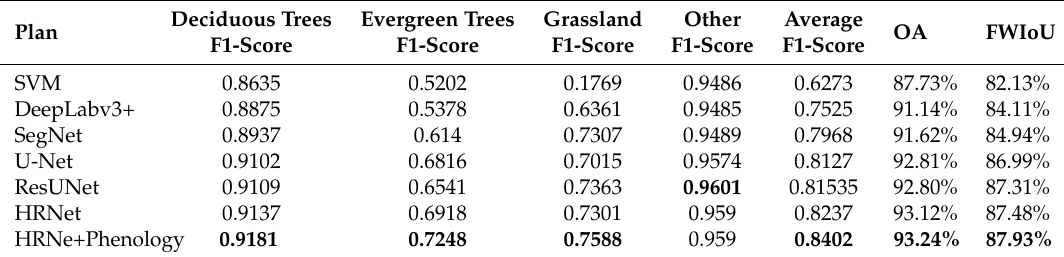
Table 2. Comparison of the accuracy of different classification